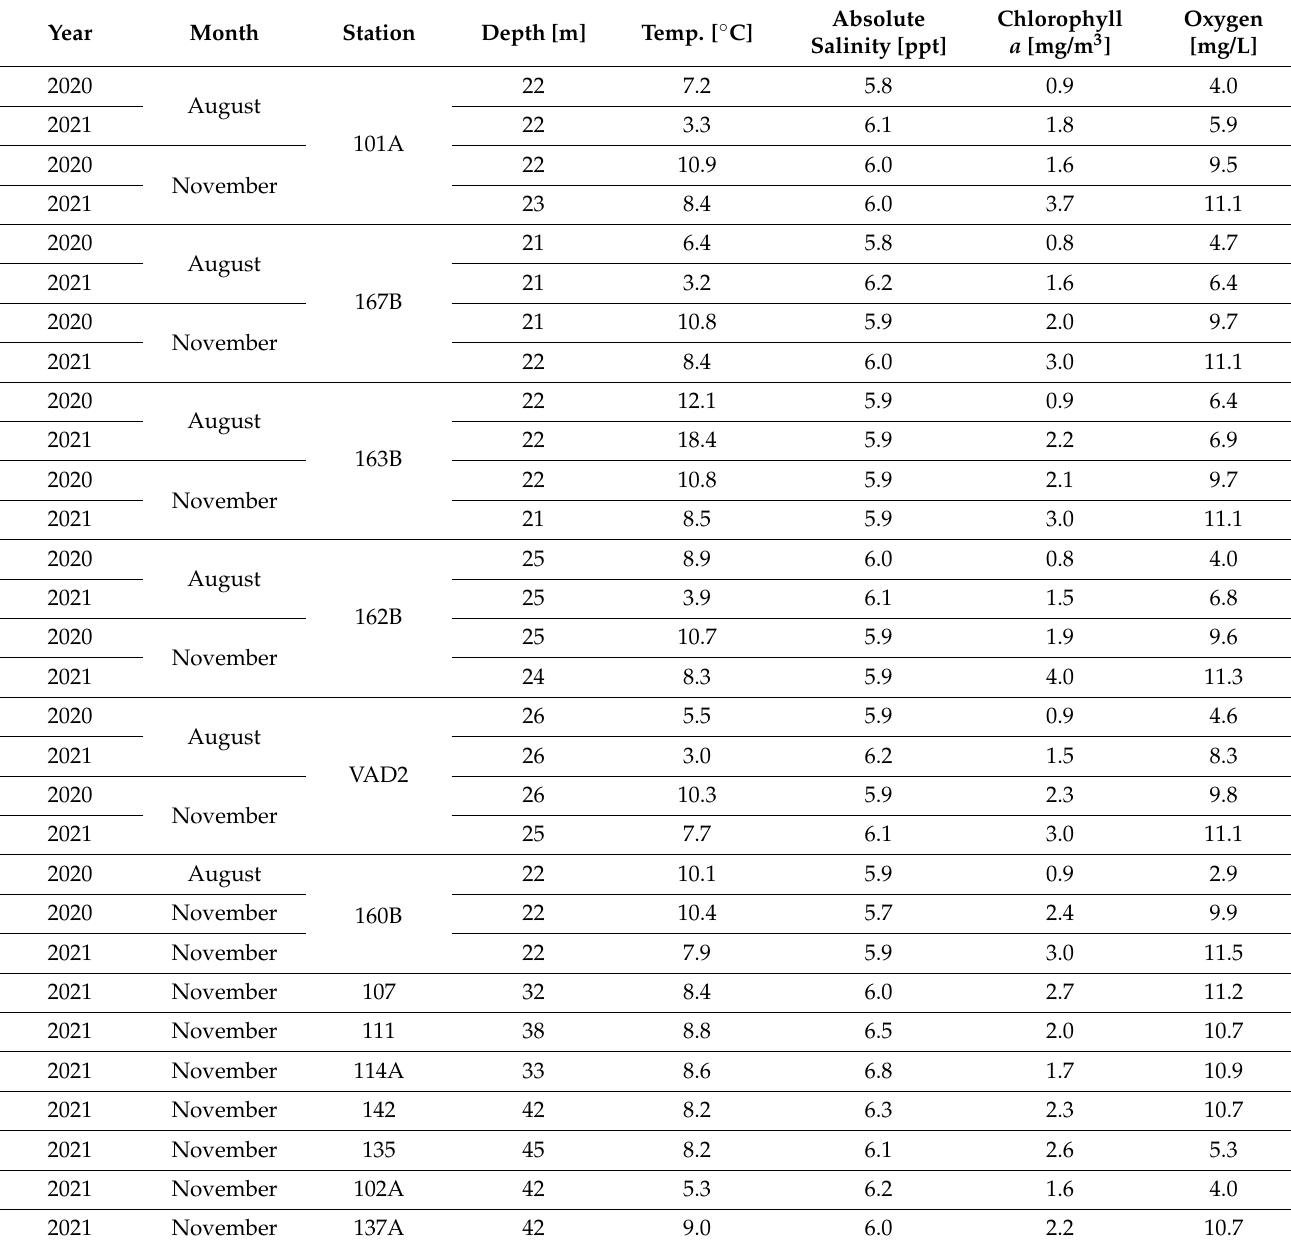
Table 1. Physicochemical parameters measured at the different study stations in the near-bottom layer in August and November 2020 and